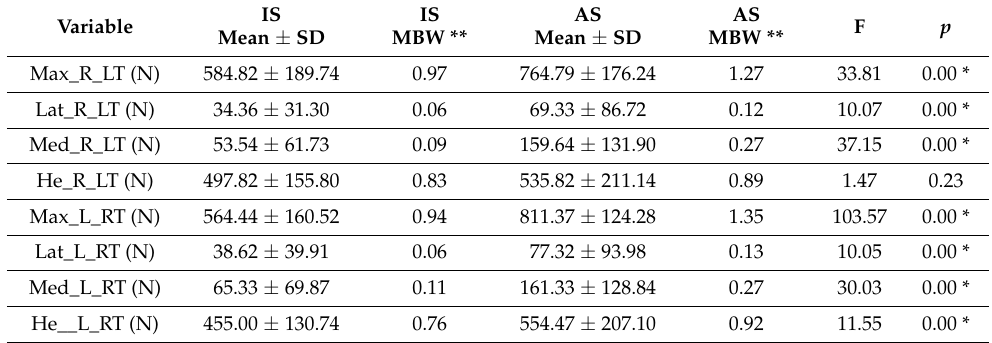
Table 3. Basic descriptive statistical parameters and MANOVA of kinetic parameters for IS and AS.